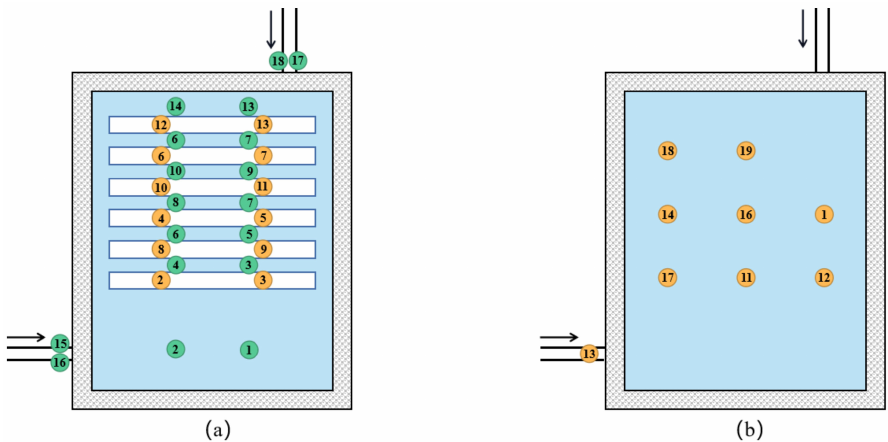
Figure 5. ( a )Test points of temperature in the PCM storage tank; ( b )Test points of temperature in the common